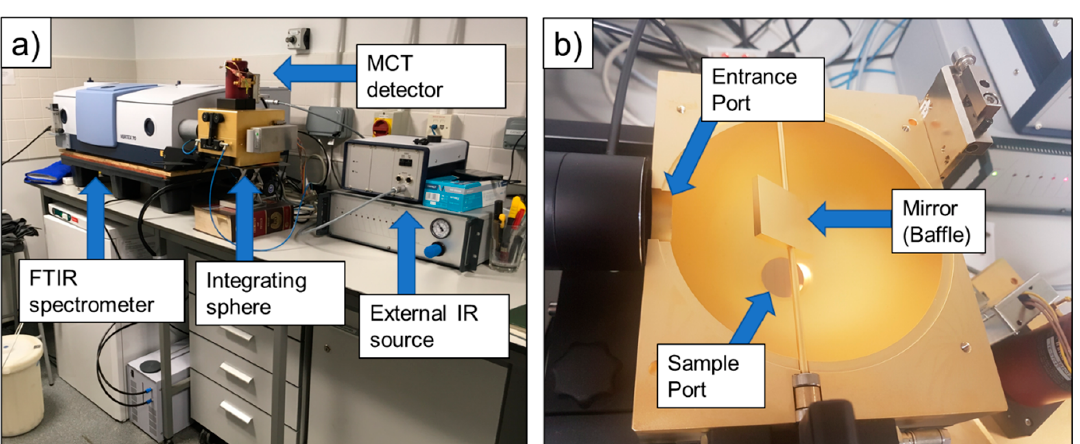
Figure 1. ( a ) Laboratory setup for surface spectral emissivity determination based on measurements made by a Bruker Vertex 70 FTIR spectrometer installed at King’s College London along with an external water-cooled longwave infrared (LWIR) radiation source and a gold-coated integrating sphere. ( b ) Details of the inside of the integrating sphere, showing the gold coating used as the reference target in the comparative method and rotating mirror to direct the measurement beam from entrance port to sample port / internal